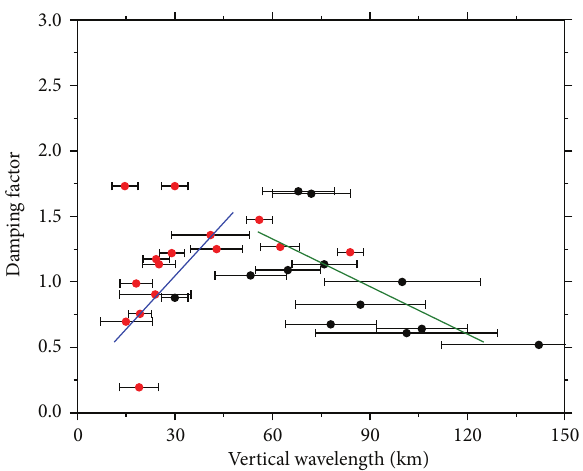
Figure 6: Variation of observed wave damping factors against the observed vertical wavelengths exhibiting a complex